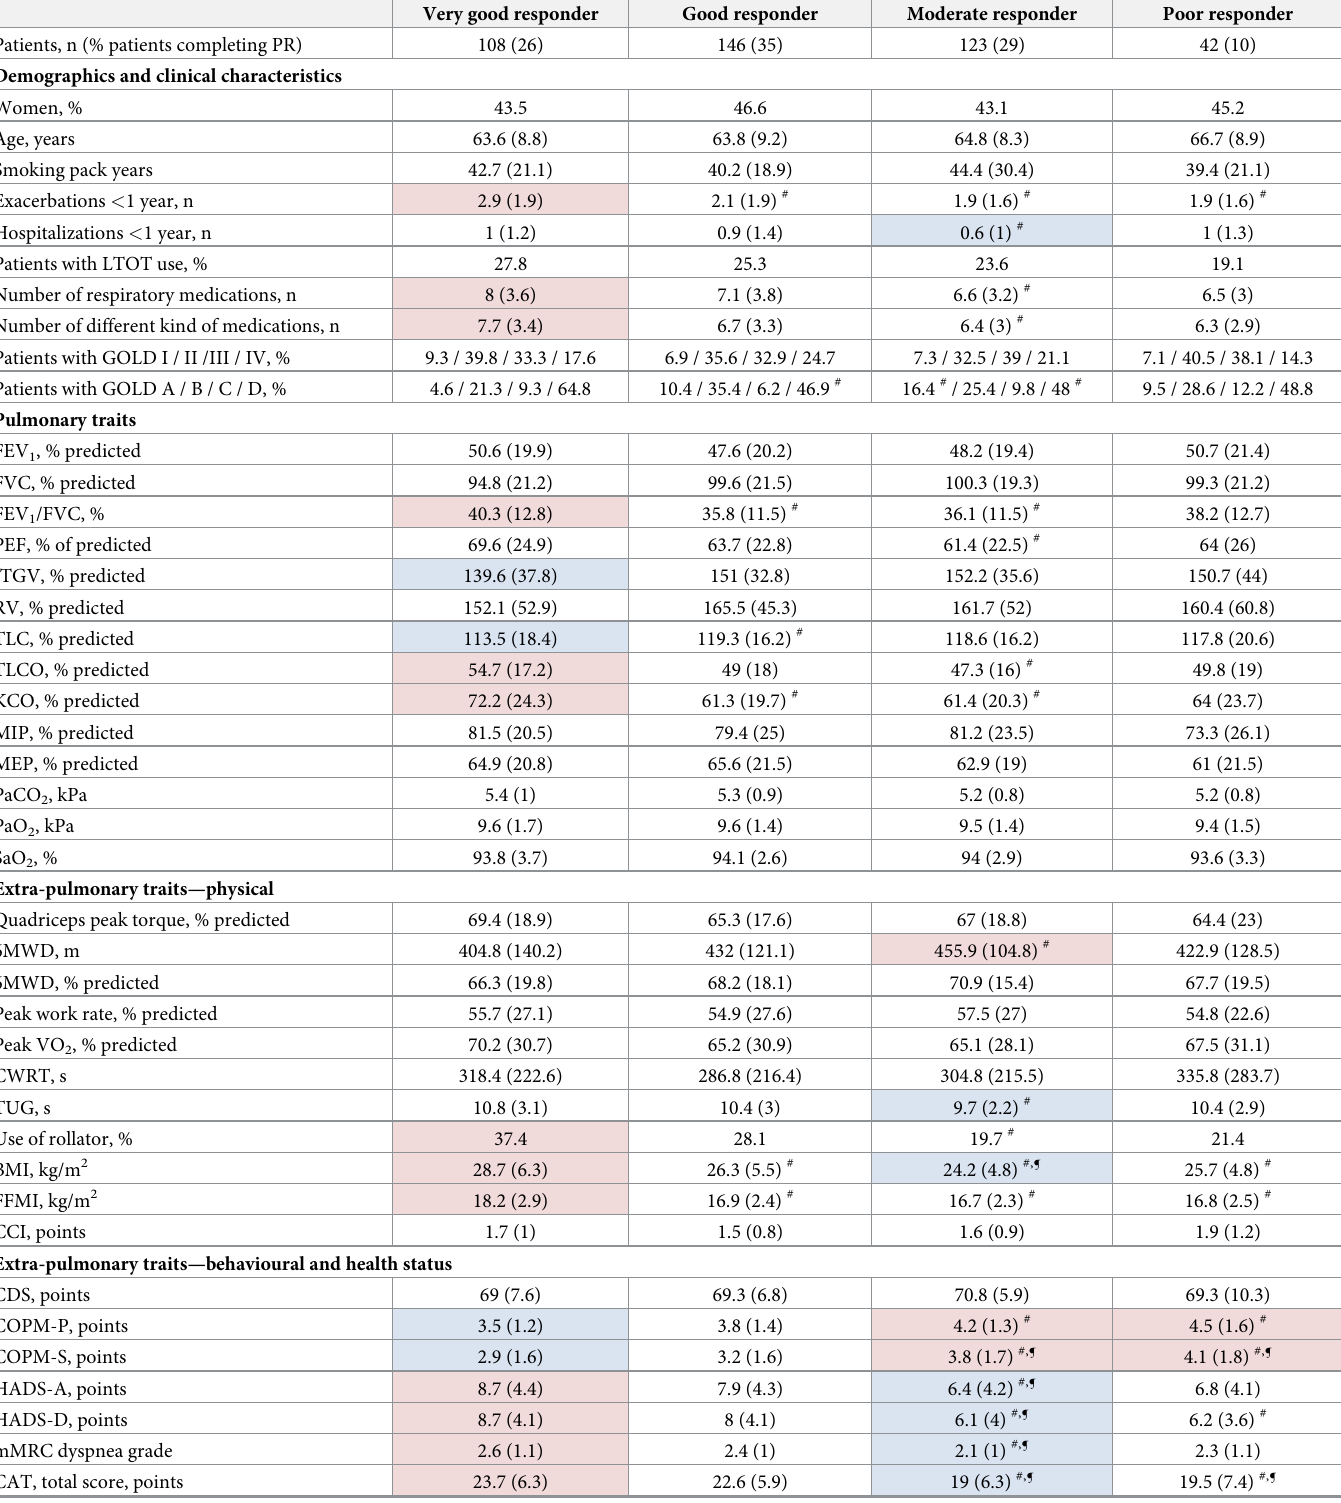
Table 3. Demographics, clinical characteristics, pulmonary, extra-pulmonary, behavioral and health status of very good, good, moderate and poor